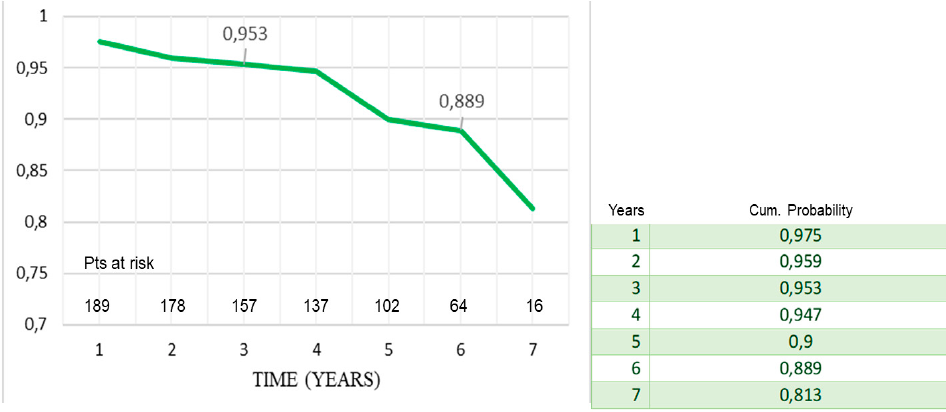
Figure 2. Event-free survival after Bentall operation.